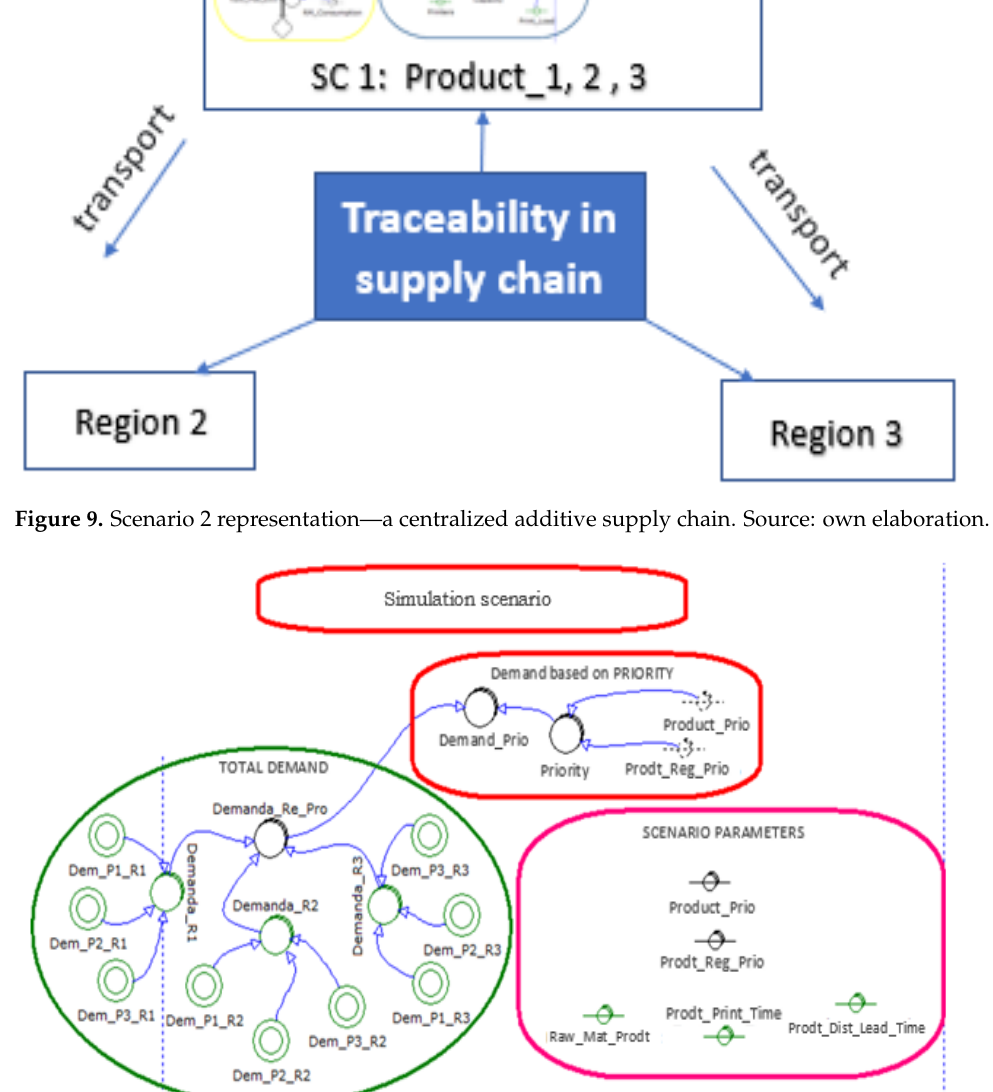
Figure 12. Supply chain structure — scenario 2. Source: own elaboration — Evolution software. Two key aspects are highlighted in this modeling. The first is that each region ’ s dis- tribution time (Prodt_D_Lead_Time) is different. The second corresponds to the printing time (Print_Time), which should establish the vector ’ s position according to the product type being processed and the attention policy established. Figure 13 presents the policy of the regions.